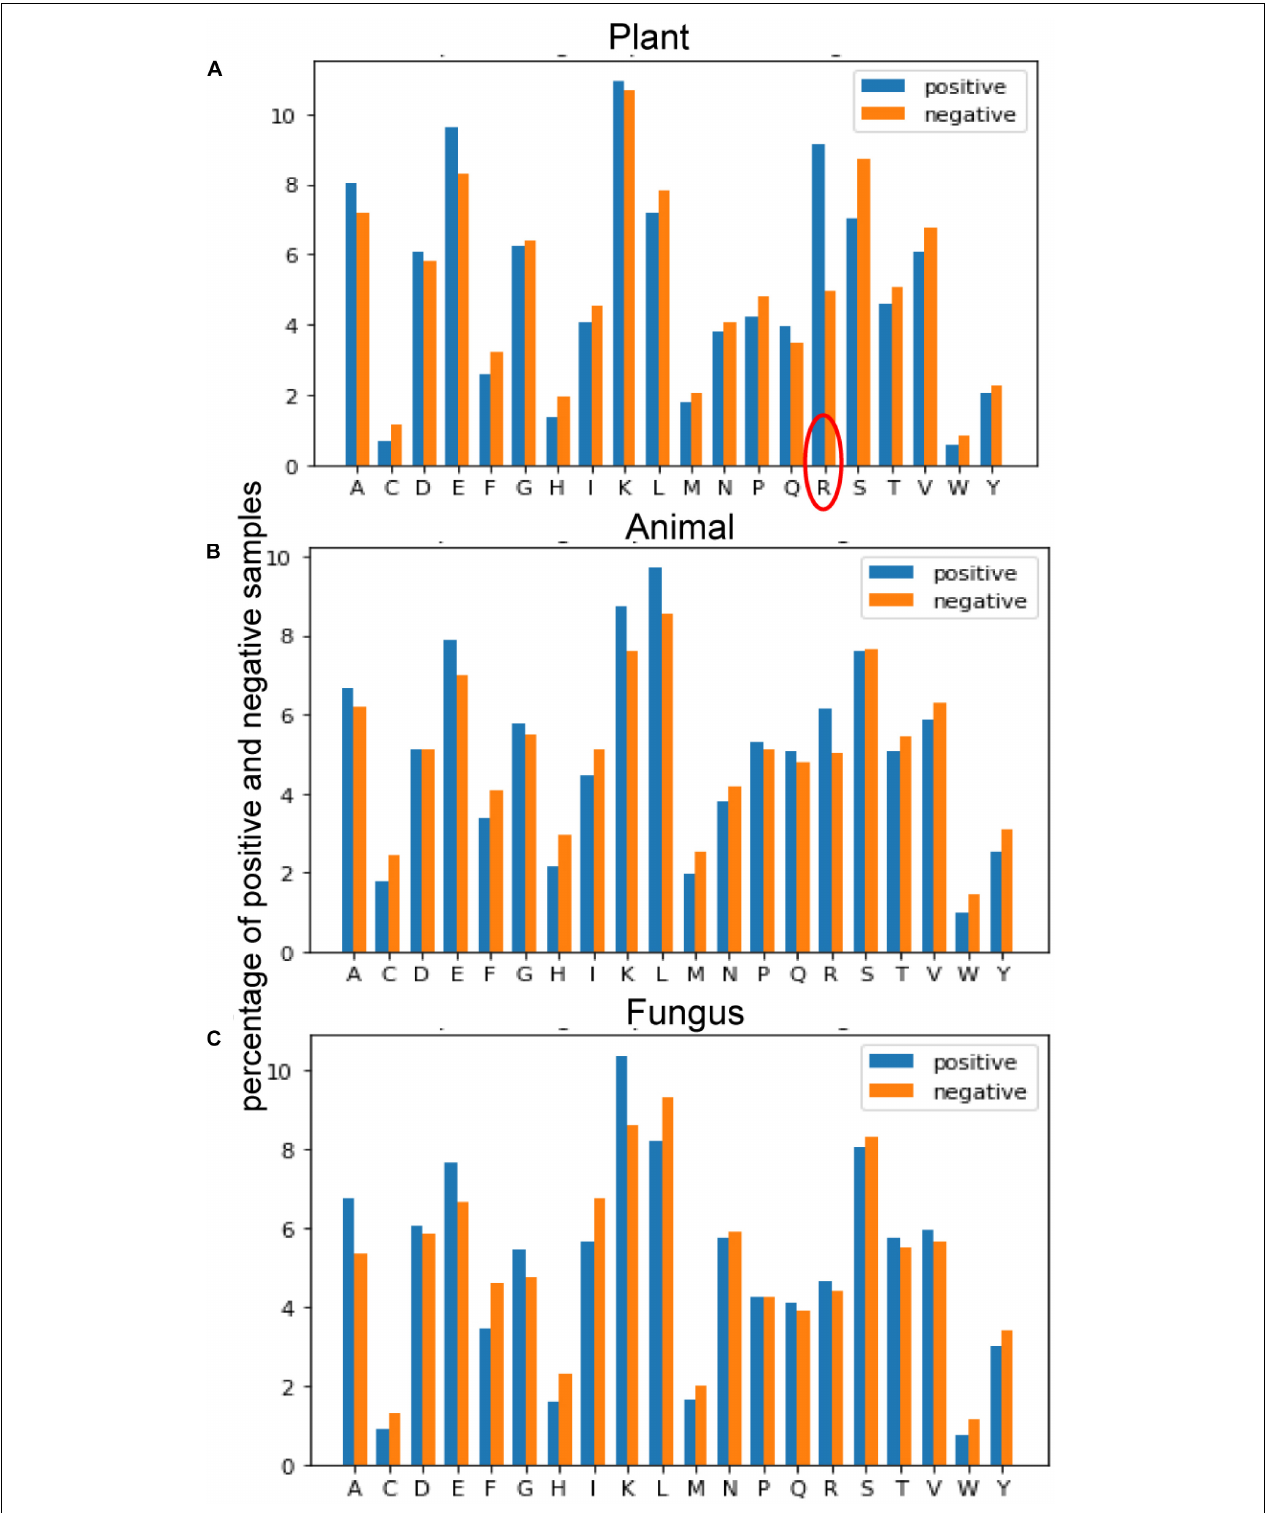
FIGURE 4 | Comparison of the amino acid composition (AAC) features between three species. (A) Comparison of AAC features between positive and negative samples of plants. (B) Comparison of AAC features between positive and negative samples of plants. (C) Comparison of AAC features between positive and negative samples of